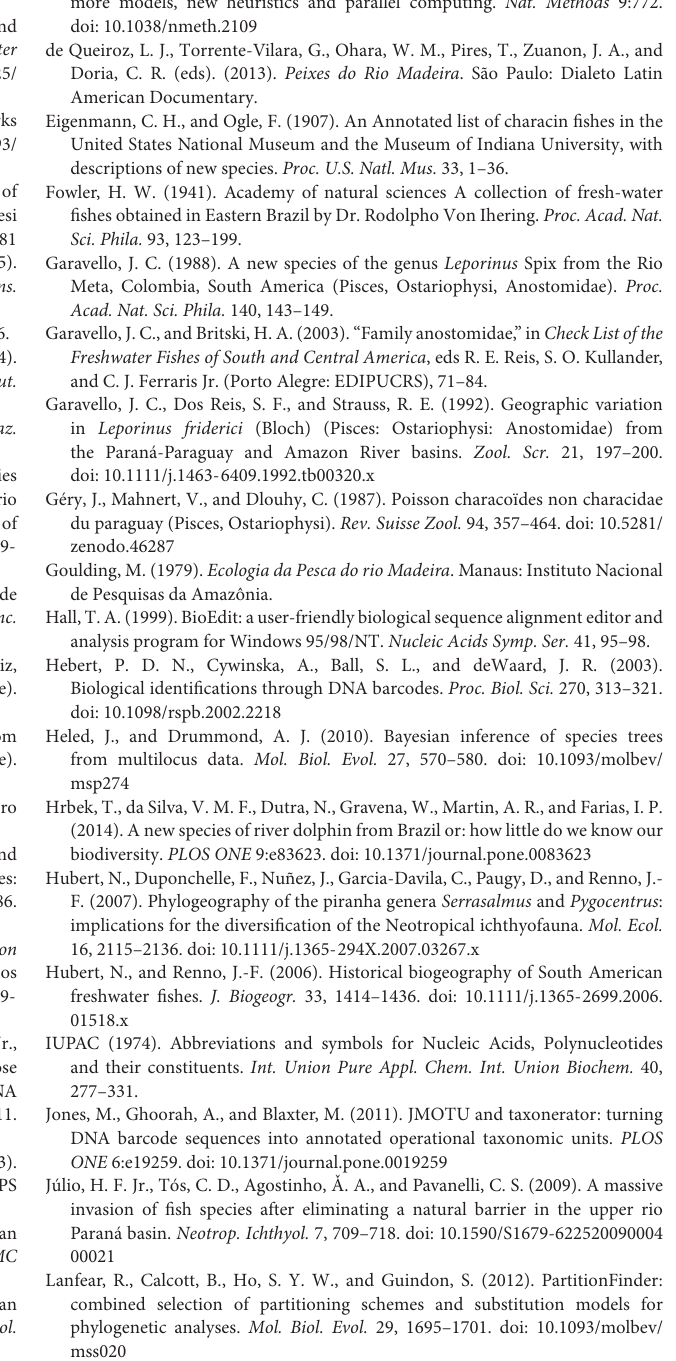
TABLE S1 | Vouchers and collection sites for all analyzed Leporinus cf. friderici . TABLE S2 | GenBank accession numbers for all analyzed species. TABLE S3 | Pairwise mean genetic distances values inter and intra-MOTU (in bold) Leporinus cf. friderici sensu stricto clade using K2p model. Values as